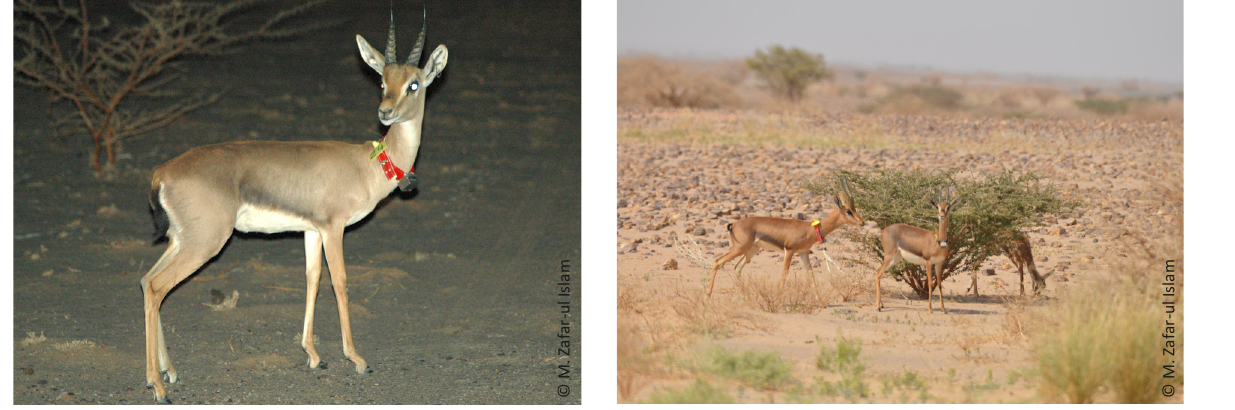
Image 1. Arabian Mountain Gazelle male in the night